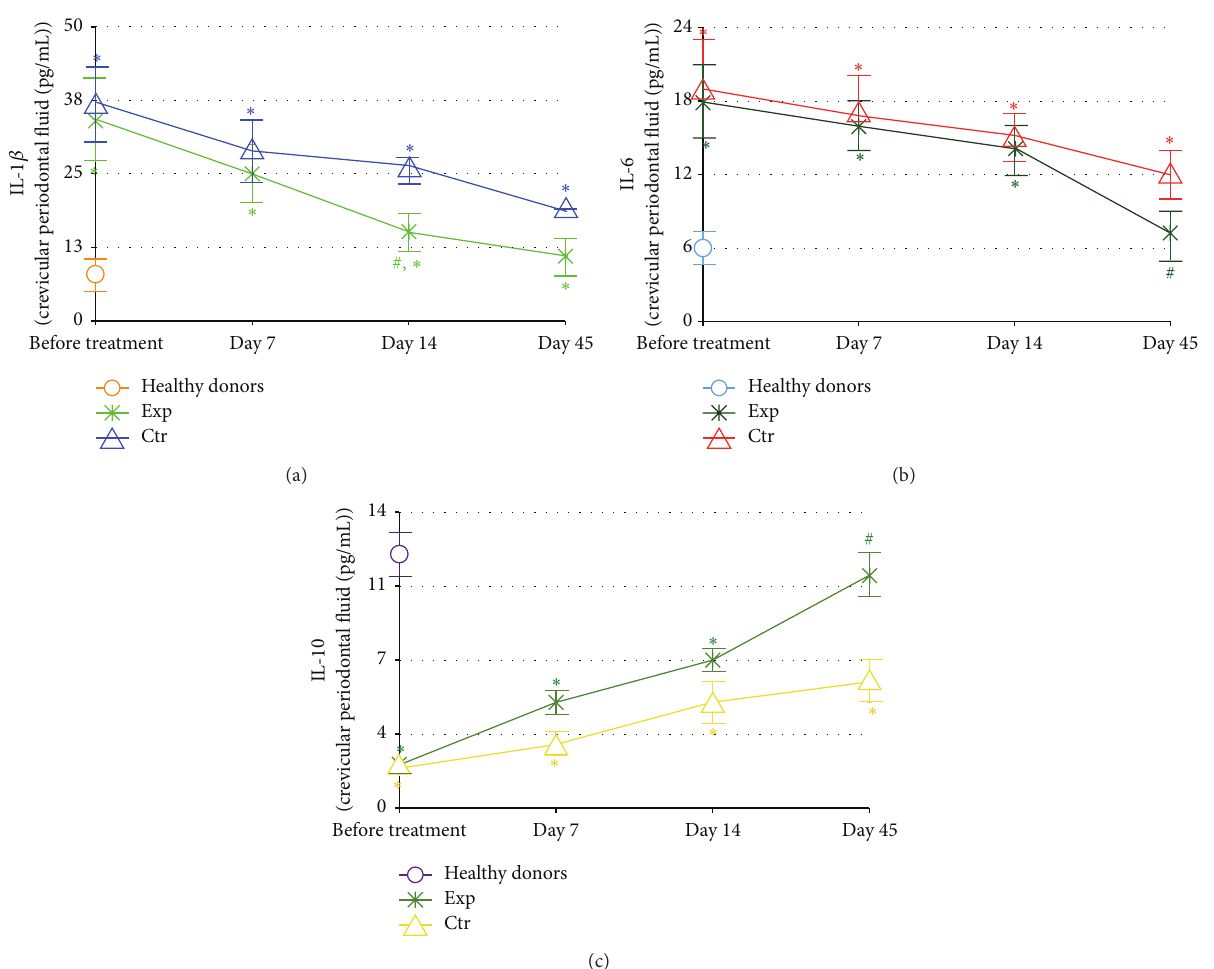
Figure 3: Dynamics of the pro- and anti-inflammatory cytokines IL-1 𝛽 (a), IL-6 (b), and IL-10 (c) in the crevicular periodontal fluid (pg/mL). The experimental group (Exp, 𝑛 = 39 ) was treated with conventional periodontal treatment plus topical daily application of fermented papaya gel into gingival pockets; the control group (Ctr, 𝑛 = 45 ) received conventional periodontal treatment for the same period of time. Healthy donors: 𝑛 = 25 .